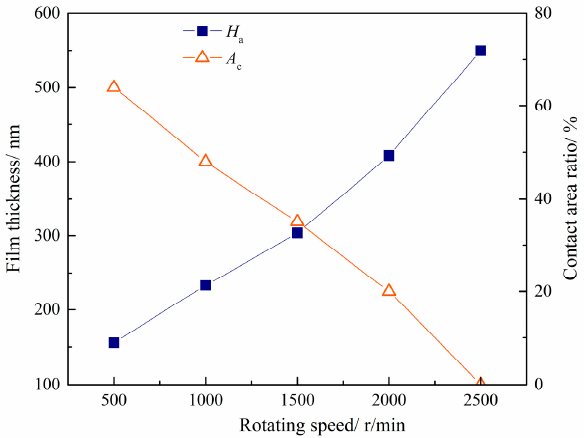
Figure 19. Film thickness and contact area ratio at different rotating speeds.